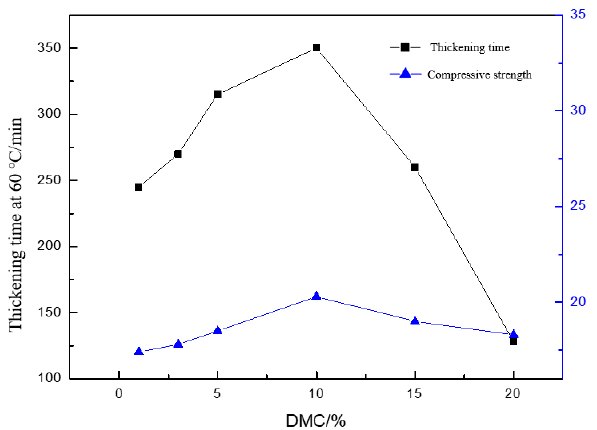
Figure 7. Effect of DMC dosage on the thickening time and compressive strength of cement slurry at 60 °C.